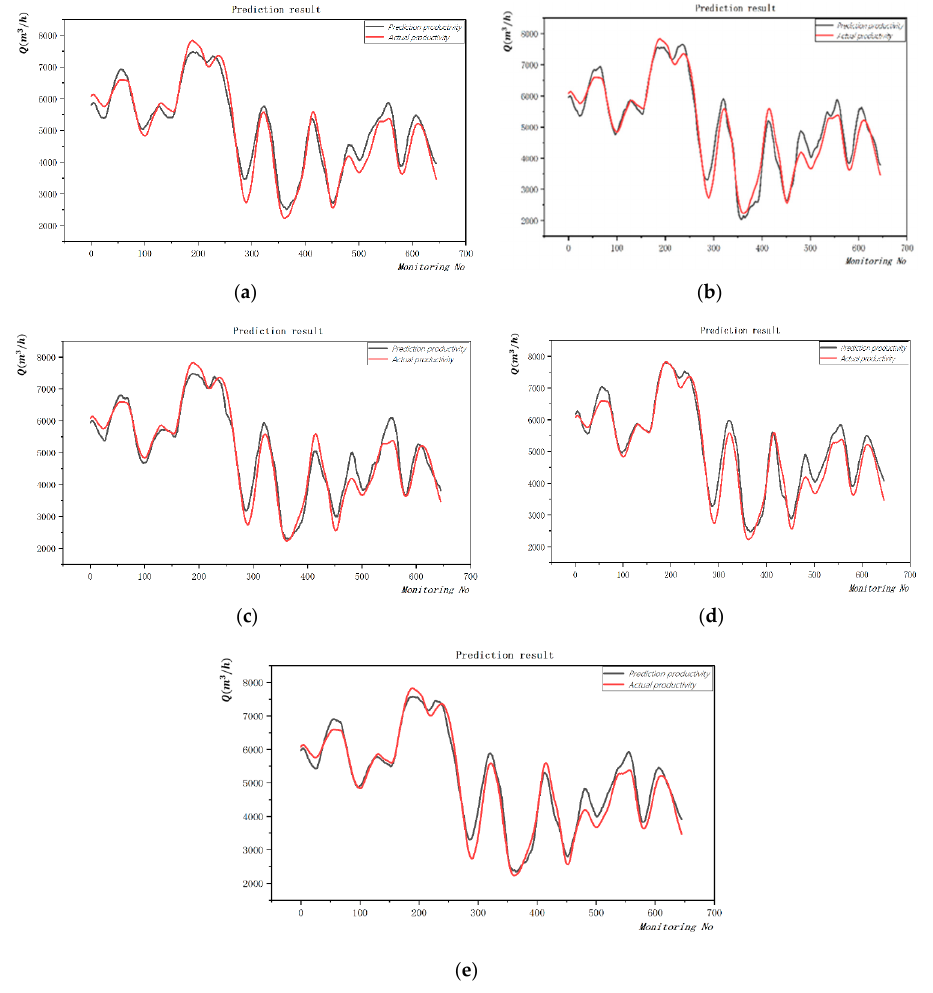
Figure 8. Prediction result. ( a ) SVR. ( b ) LSTM. ( c ) MLP. ( d ) DBN. ( e ) WCM. According to the weight combination formula, the combined weight is allocated ac- cording to the goodness of fit ( 𝑅 (cid:2870) ) predicted by each model. The final weight allocation of SVR, MLP, LSTM, and DBN is 0.2504, 0.2508, 0.2494, and 0.2494, respectively. Table 3. Super parameters and evaluation indexes of each algorithm.